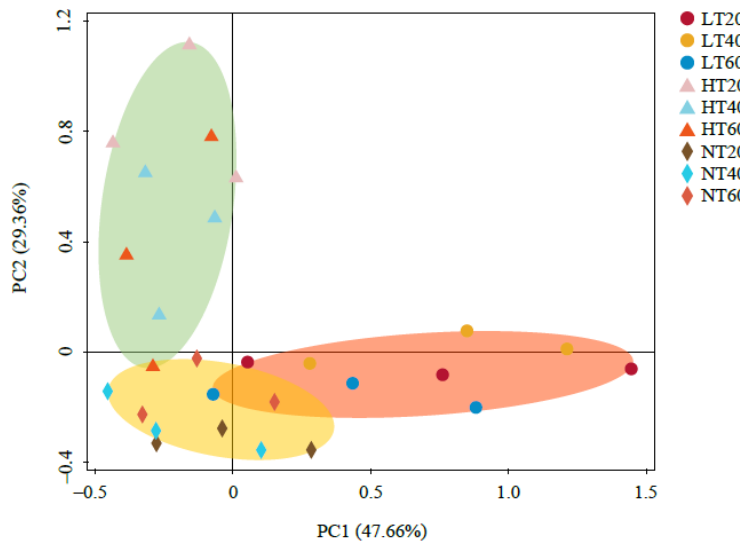
Figure 3. Principal coordinate analysis (PCoA) of soil bacterial community.